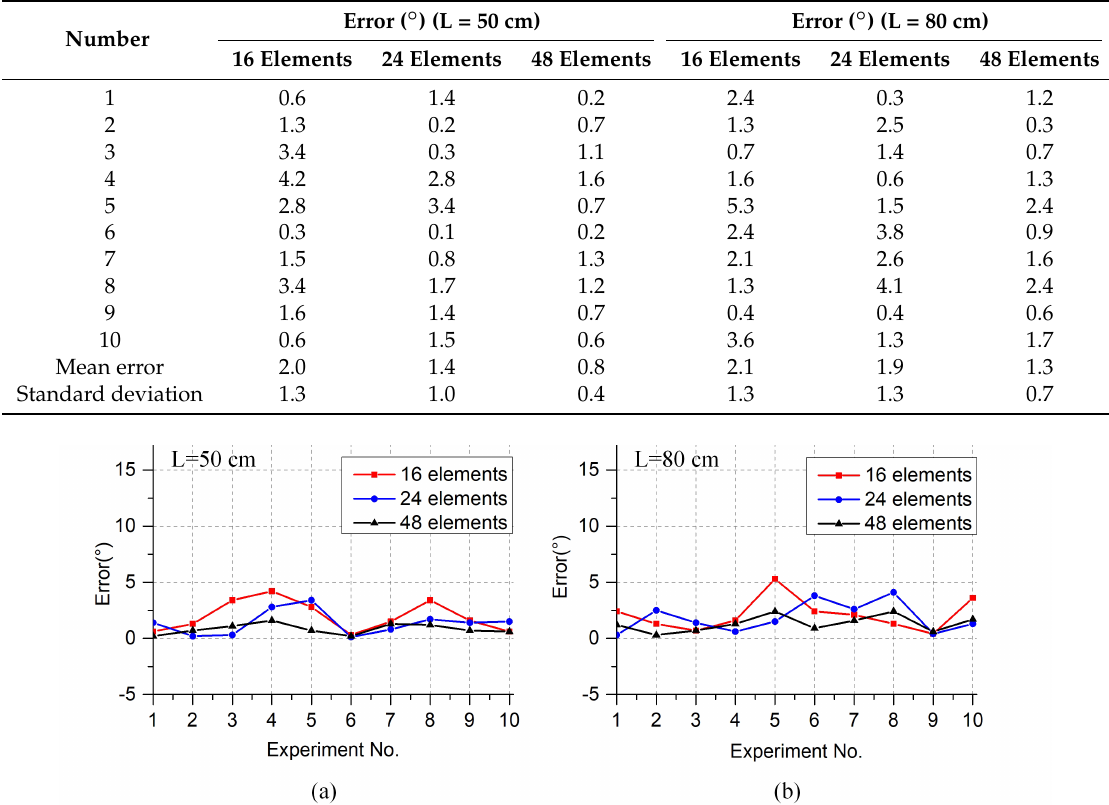
Figure 8. ( a ) Error analysis when the distance is 50 cm. ( b ) Error analysis when the distance is 80